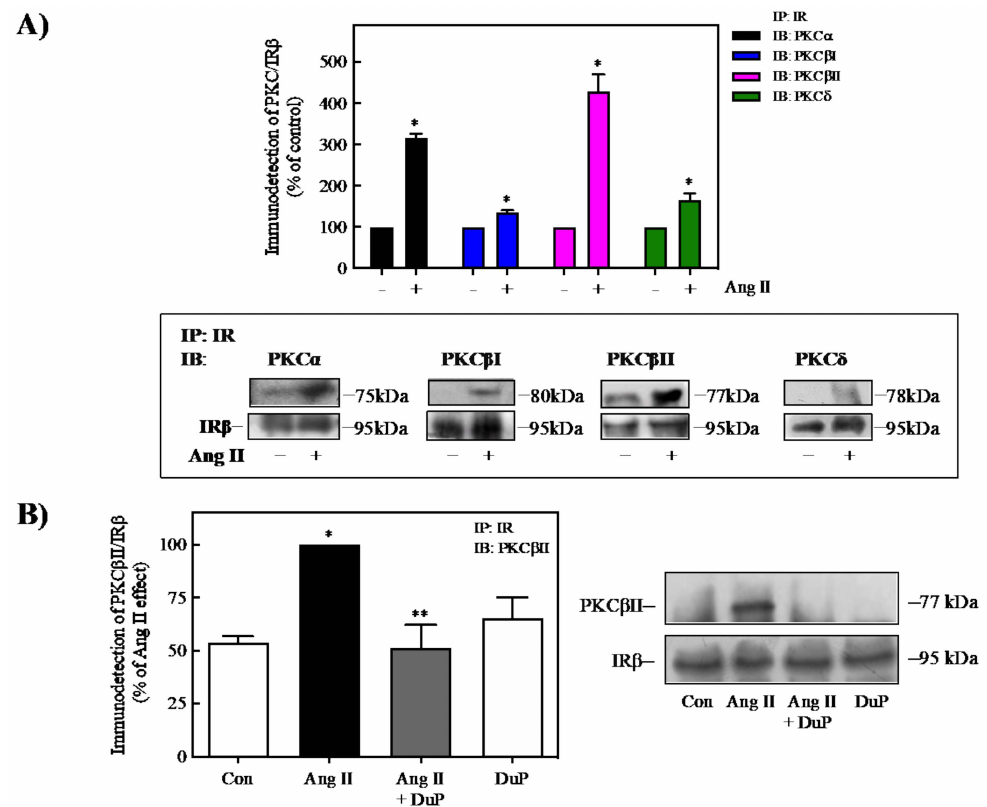
Figure 6. Ang II promotes the association of IR and classical and new isoforms of PKC. ( A ) 3T3-L1 adipocytes were pretreated with or without 100 nM Ang II for 60 min. ( B ) Cells were pretreated in the absence or presence of 10 µ M DuP 753 for 30 min before treatment with 100 nM Ang II for 60 min. Under all experimental conditions, cells without treatment were considered as controls. Total cell lysates were immunoprecipitated with anti-IR before SDS-PAGE analysis and immunoblotted with anti-PKC α , anti-PKC β I, anti-PKC δ ( A ), or anti-PKC β II ( A , B ). Blots were quantitated by densitometry, and the mean values were plotted from three-five independent experiments. Vertical lines represent the S.E.M. Representative immunoblots are presented. Western blots were also probed for total IR β . ( A ) * p < 0.05 vs. Con ( − ). ( B ) * p < 0.05 vs. Con; ** p < 0.05 vs. Ang II. Con, control; DuP, DuP